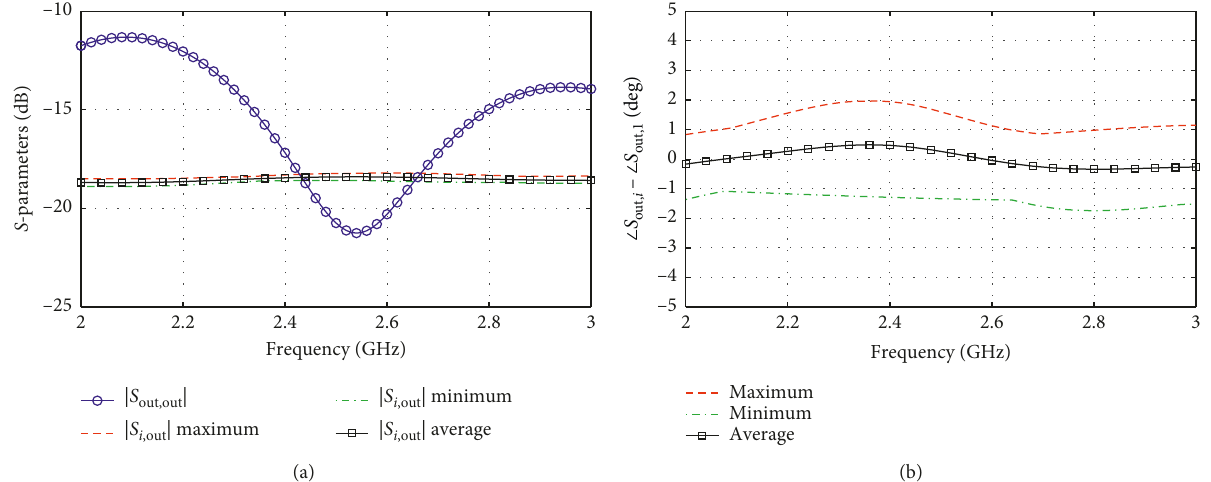
Figure 6: Simulated S -parameters of the 8 × 8 combining network. (a) Magnitude of S